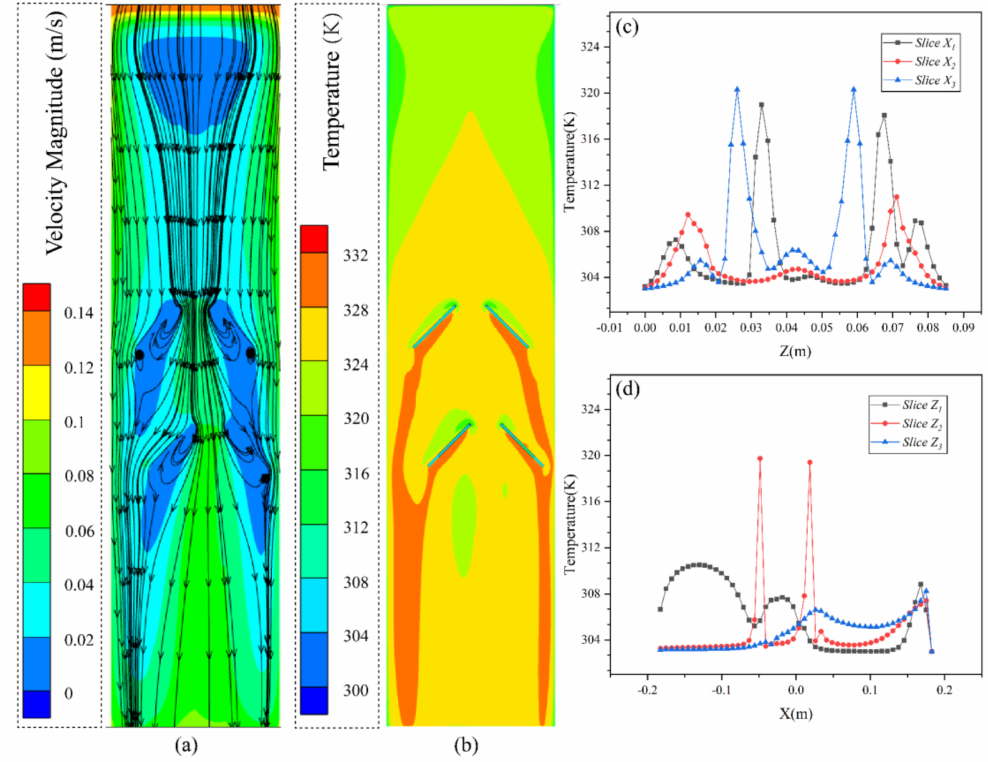
Figure 13. Diagrams of FU -4 h − 0.5 h under steady state conditions, ( a ) streamline diagram, ( b ) temperature contour diagram, ( c ) slice temperature diagram in X direction, ( d ) slice temperature diagram in Z